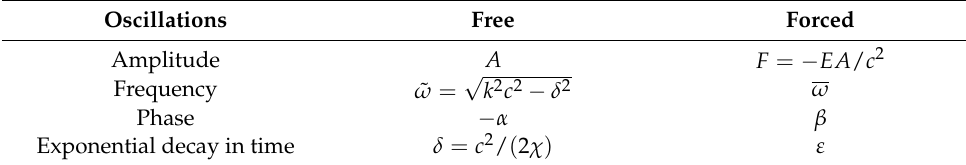
Table 4. Comparison of free and forced oscillations. Oscillations